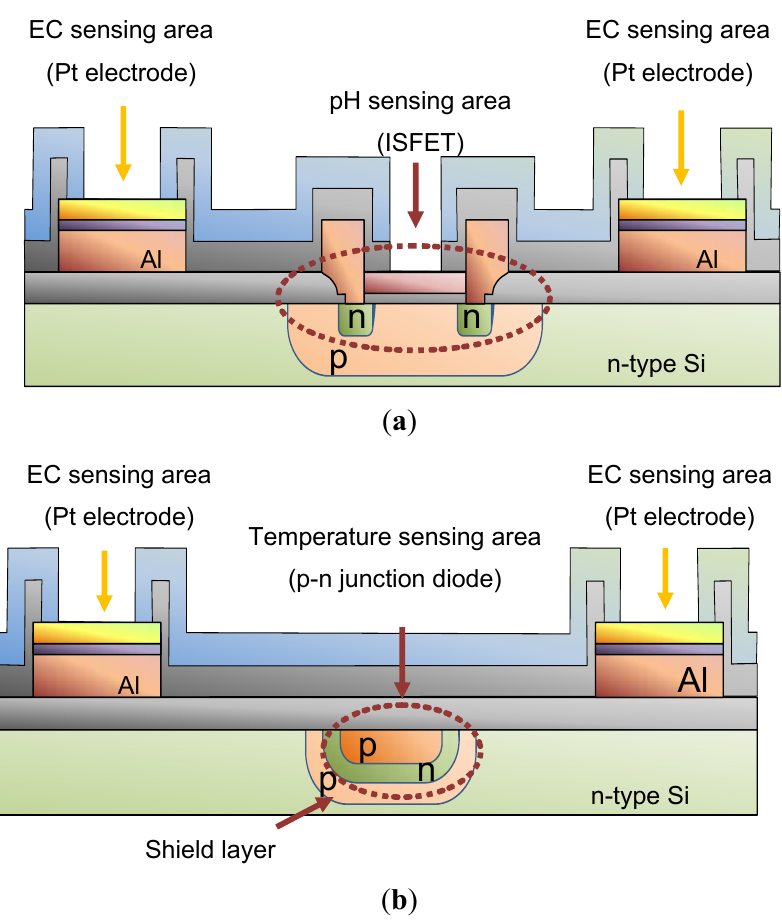
Figure 4. Schematic cross-sections through the multimodal sensor chip. ( a ) The pH and EC sensing areas through A-A’ in Figure 3. The pH sensing area is between the Pt electrodes; ( b ) The temperature and EC sensing areas through B-B’ in Figure 3. The temperature sensing area is also between the